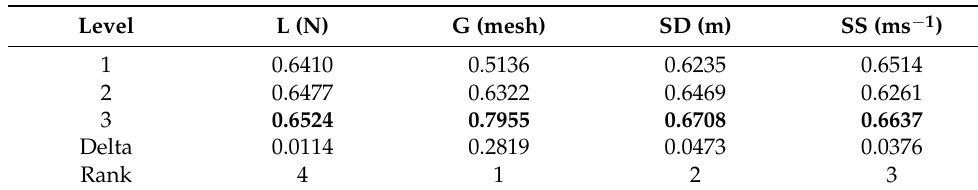
Table 8. Response table for means of GRG.